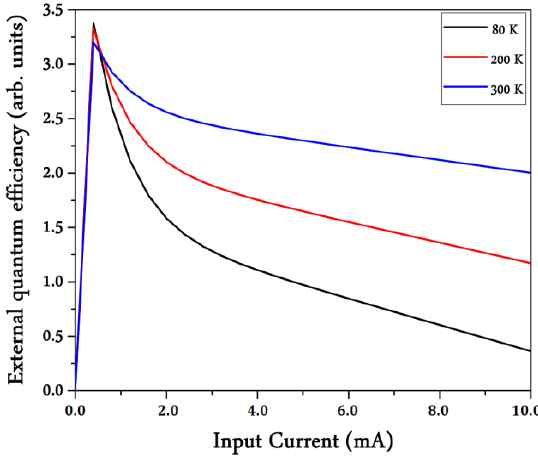
Figure 13. External quantum efficiency (EQE) vs. injection current at different temperatures for semipolar (112 ̅ 2)-oriented InGaN blue laser.